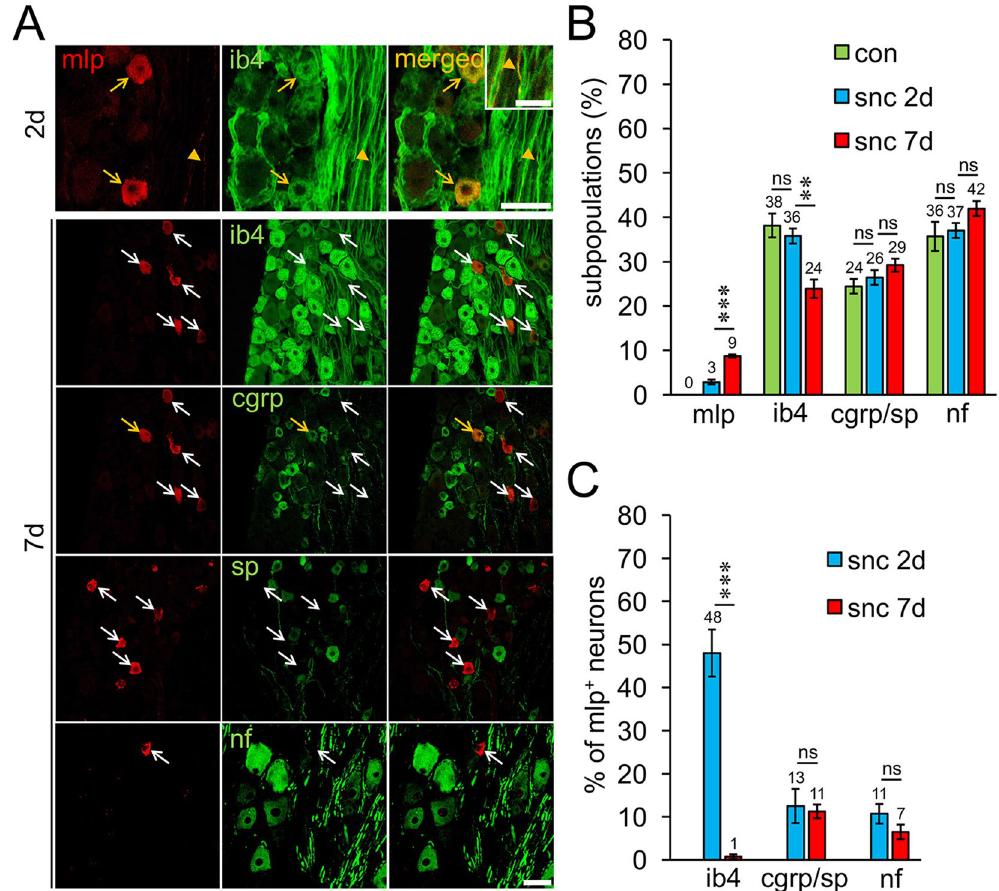
Figure 3. MLP is mainly expressed in nociceptive DRG neurons. ( A ) L4/L5 DRG sections prepared 2 and 7 days after sciatic nerve crush (snc) were co-stained for MLP (red) and one of four markers of neuronal DRG subpopulations (green): isolectin B4 (ib4), calcitonin gene related peptide (cgrp), substance P (sp) or 200 kDa neurofilament (nf). Many MLP-positive DRG neurons (yellow arrows) and their axons (yellow arrowhead) were positively stained for IB4 at 2 days after snc. In contrast, only very few double-positive cells (yellow arrow) were found at 7 days after snc, while most MLP-positive neurons did not co-express any of the four canonical markers (white arrows). Co-staining of MLP for IB4 and CGRP 7 days after snc was performed as triple staining on the same DRG section. Original blue color of CGRP signal was changed to green for a better visualization of positive cells. Scale bars: 50 µ m, 25 µ m for insert showing higher magnification of a MLP/IB4 double- positive axon. ( B ) Quantification of mlp-, ib4-, cgrp/sp- and nf-subpopulations in DRG from either untreated adult male rats (con) or at 2 and 7 d.p.c. in relation to all β III-tubulin-positive neurons. Data represent mean percentages ± SEM from 2 rats per experimental group and 4 sections per DRG. Only the subpopulations of MLP- and IB4-positive neurons changed after sciatic nerve crush. ( C ) Percentage of neurons double-positive for MLP and either ib4, cgrp/sp or nf on sections as described in ( A ) at 2 and 7 days after snc. Treatment effects: ** p < 0.01, *** p < 0.001, ns: